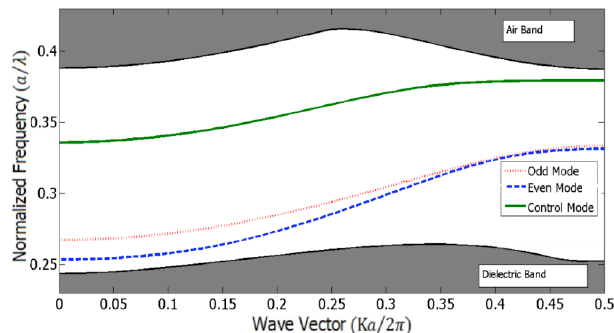
Figure 3: Band structure of the proposed all-optical switch shown in Fig.